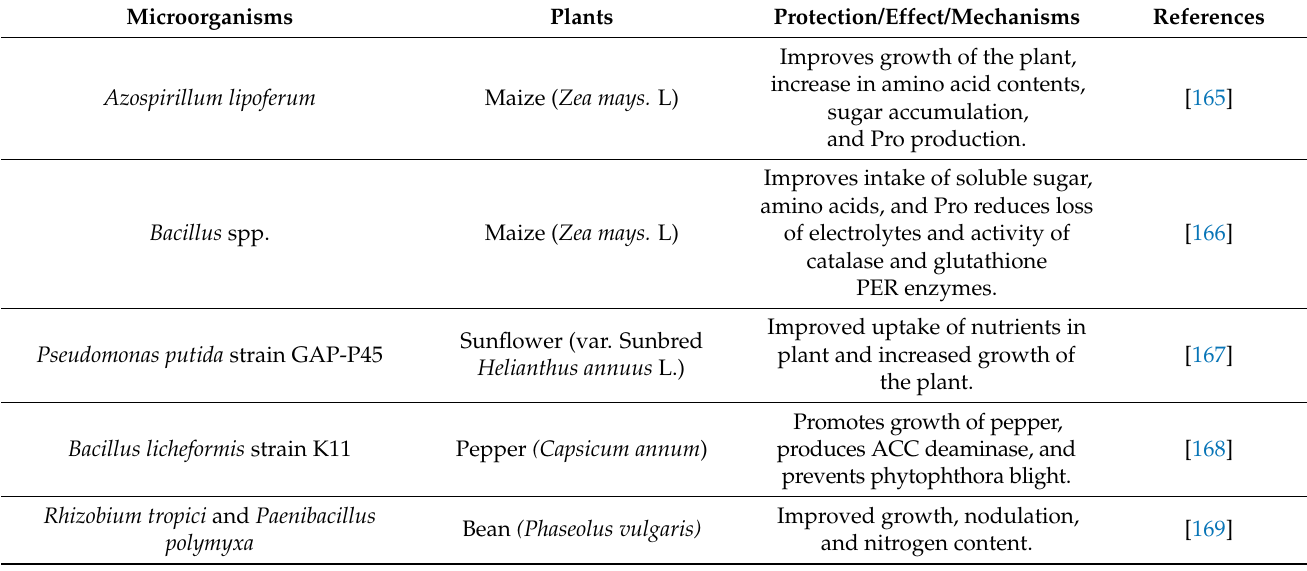
Table 5. Plant growth-promoting mechanisms by PGPR in drought stress conditions. Microorganisms Plants